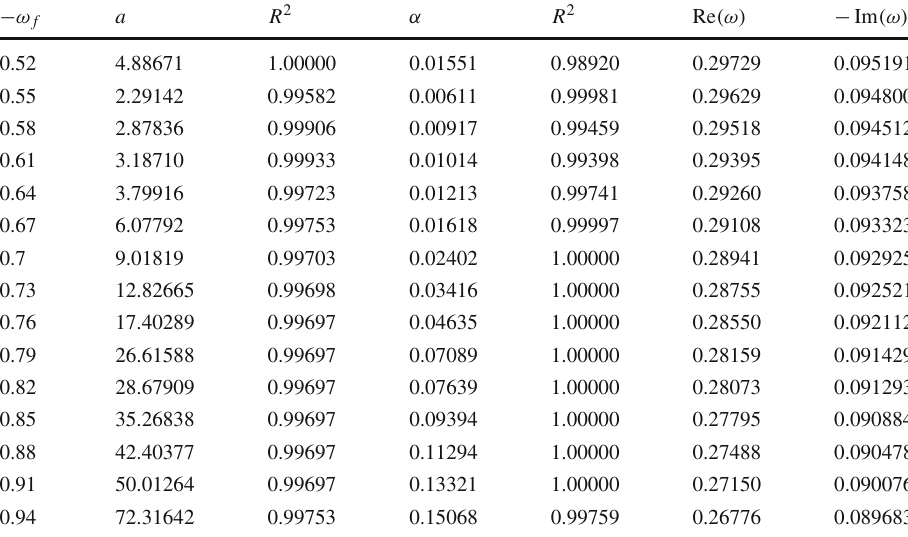
and late-time behavior of the RN black hole with anisotropic fluid in a geometry with M = 2 Q = 100 c = 1. The scalar field angular momentum reads l =